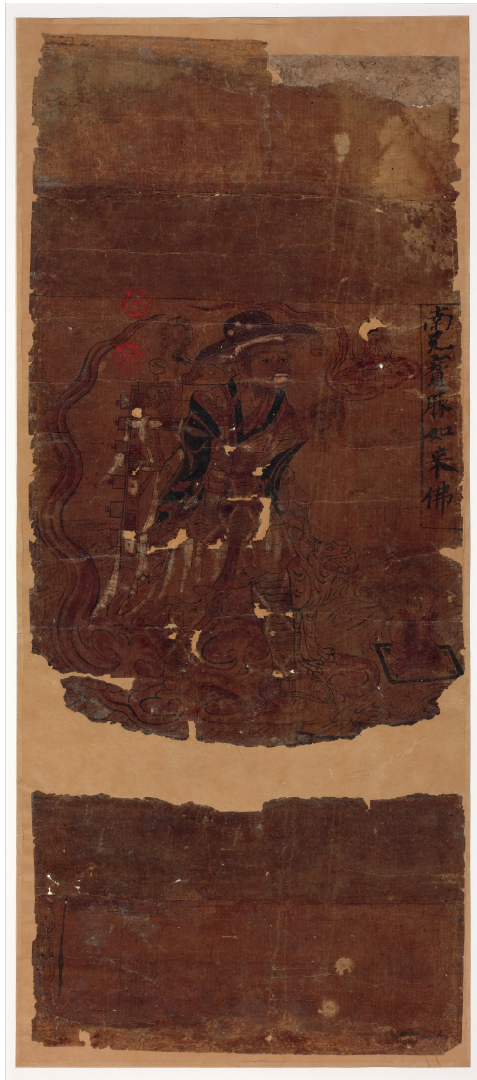
Figure 16. Itinerant Monk . Dunhuang, 10th century. Ink and colors on paper, 71.0 × 29.0 cm. Biblioth è que nationale de France (Pellio chinois